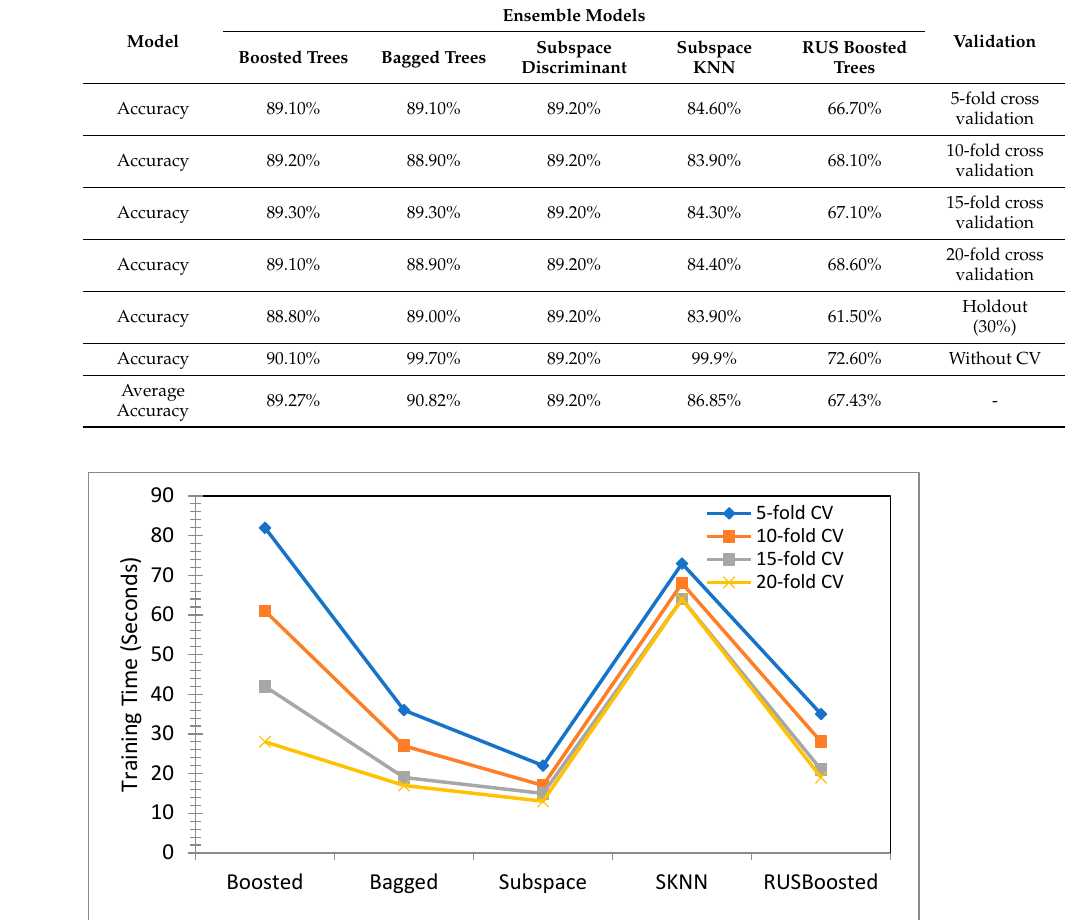
Figure 6. Training time comparison for various ensemble models for the holdout method and with no cross-validation. Table 5. Various validation parameters on 5-fold CV. Table 4. Ensemble accuracies with dimensionality reduction versus CV.